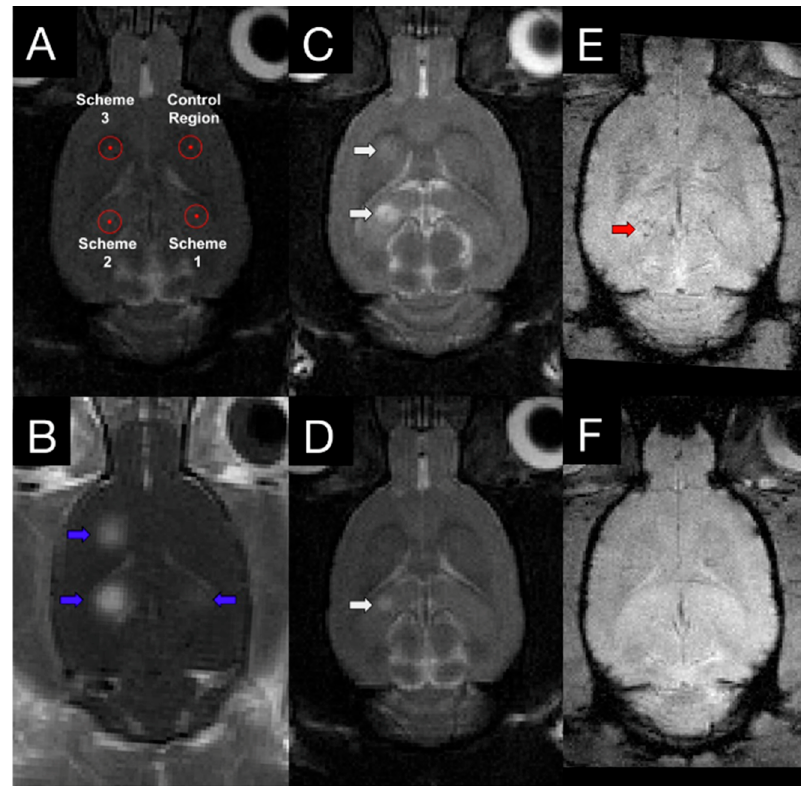
Figure 2. T1w, T2w, and T2*w images following FUS treatment. ( A ) Three sonication targets with different FUS parameters (scheme 1: acoustic controller was used with 10 μ L/kg microbubbles; scheme 2: fixed 0.29 MPa was used with 100 μ L/kg microbubbles; scheme 3: acoustic controller was used with 100 μ L/kg microbubbles) and one control area were chosen based on T2w image. ( B ) Contrast-enhanced T1w image showed increased BBB modulation region, indicating with blue arrows. T2w images at 4 h ( C ) and 4 days ( D ) following FUS treatment demonstrated different degrees of edema at schemes 2 and 3 (white arrows). T2* images were also acquired at 4 h ( E ) and 4 days ( F ) post-sonication. Hypointensity in T2* (red arrows) was observed in one animal at scheme 2. With the proper control of FUS parameters, a safe and reversible BBB permeability modulation could be achieved. Adapted from [56], Theranostics, 2017.